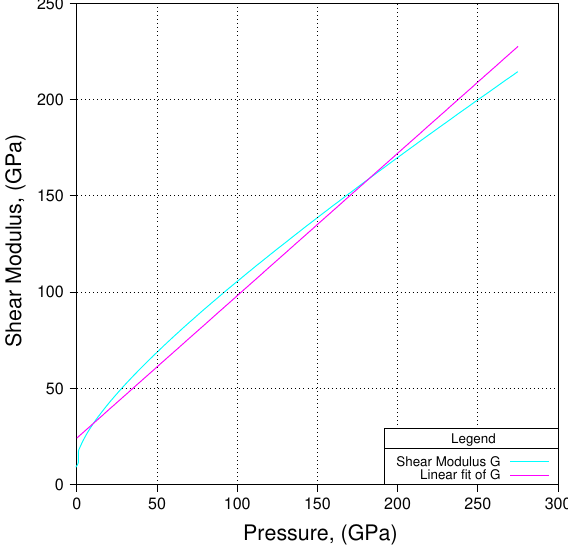
Figure 4. Shear modulus as a function of